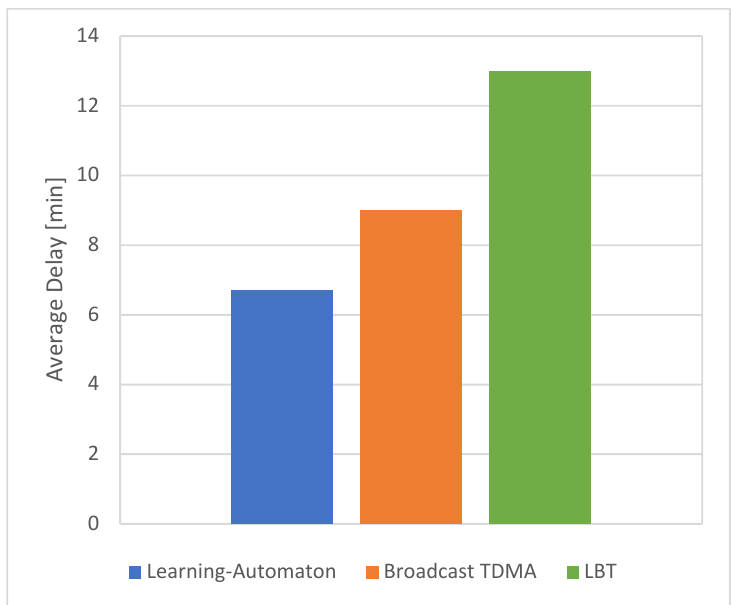
Figure 10. Average delay for variable traffic load for each SET.